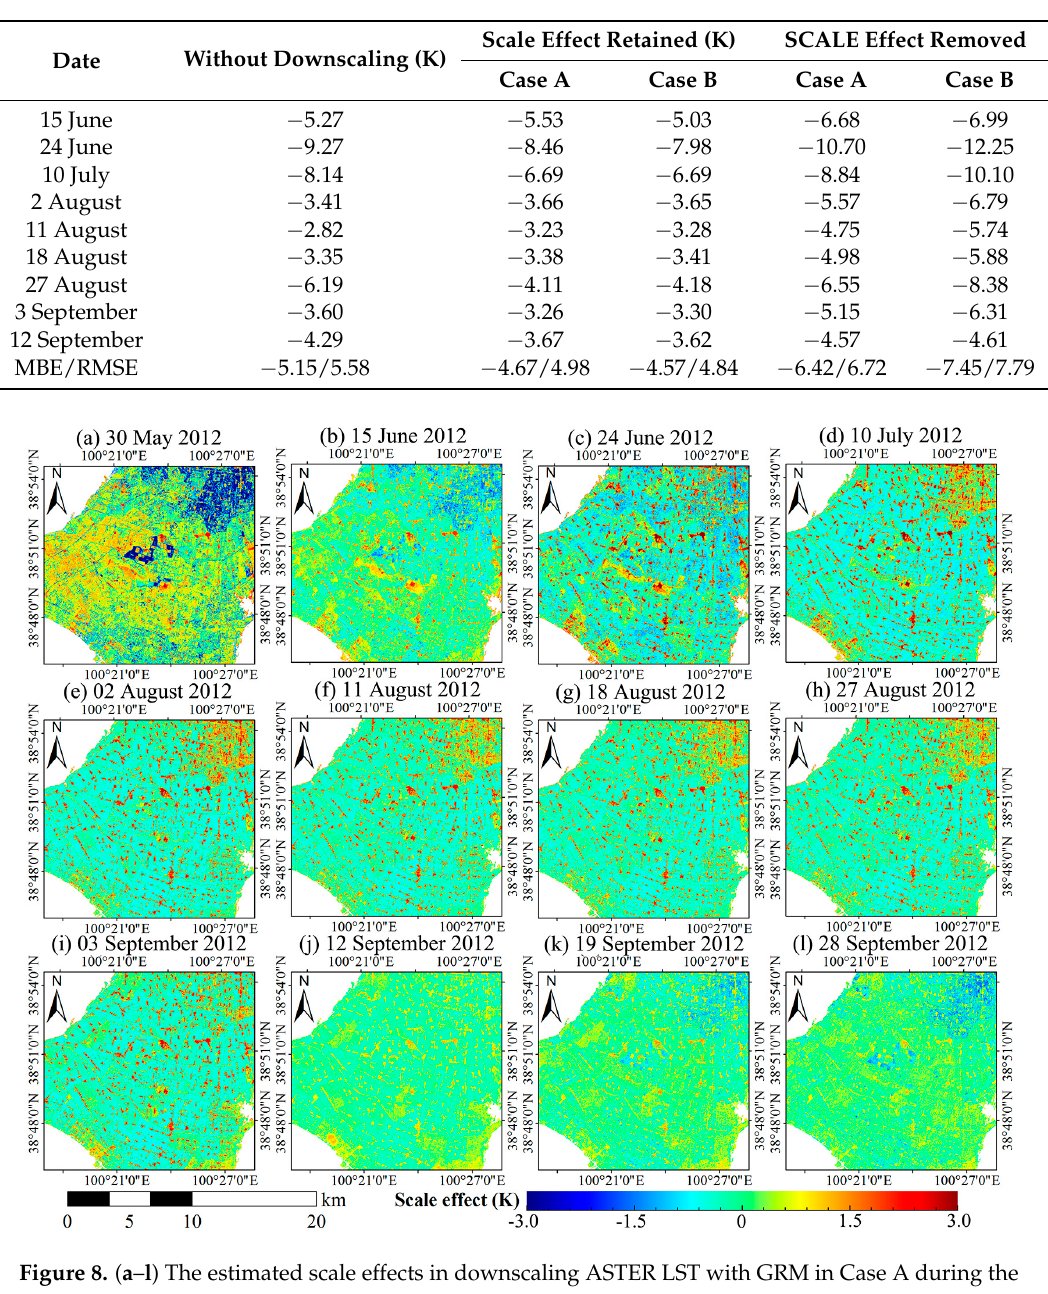
Table 3. Errors of the LSTs downscaled with GRM validated based on in situ LSTs at EC04.